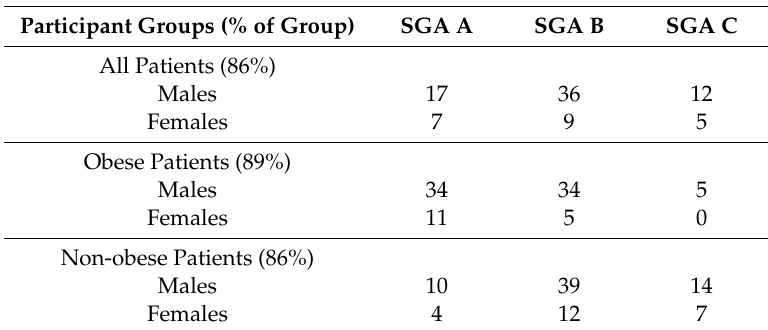
Table 2. Body mass index (BMI), subjective global assessment of nutritional status (SGA) and muscle wasting. % Patients with Significant Muscle Wasting per SGA Group